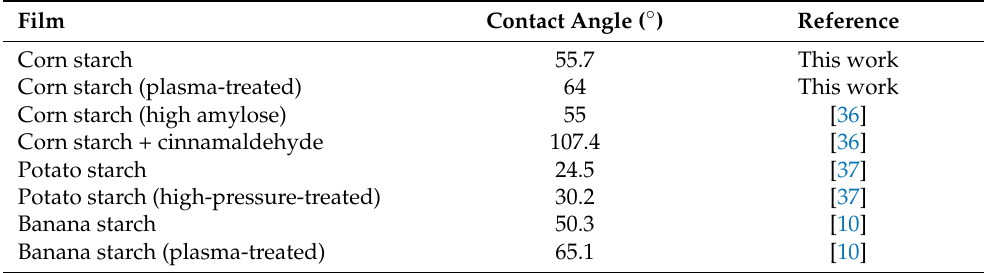
Table 4. The contact angles of several starches, bacterial cellulose, and gelatin films reported in the